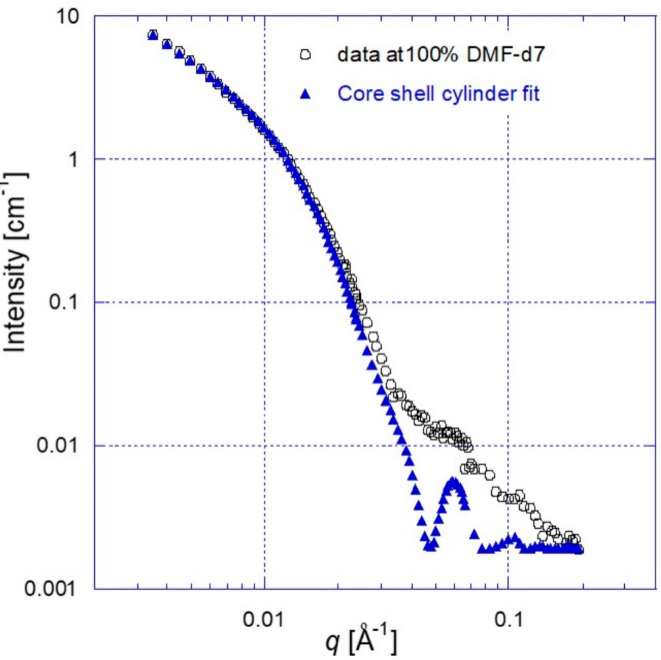
Figure 11. A core–shell cylinder model fit to the 0.5 wt.% MWCNT + 1 wt.% S 12 -4VP 12 scattering data at 100 wt.% DMF-d7 solvent (background